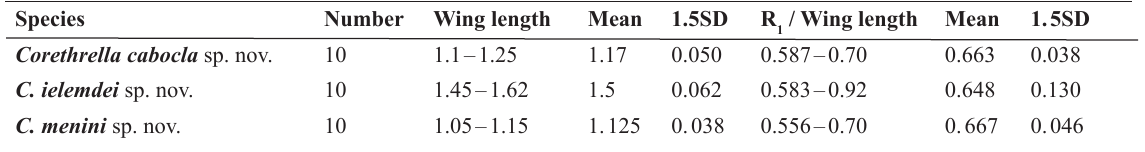
/ Wing length Mean 1. 1